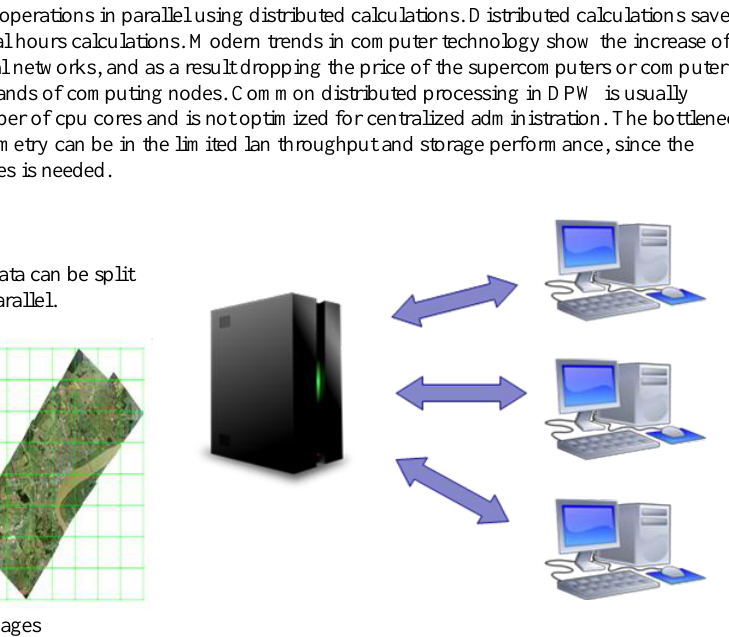
Figure 2. Conventional approach: many workstations and one server This approach is not efficient when modern computer clusters are used. 2. DISTRIBUTED PROCESSING ON COMUTER